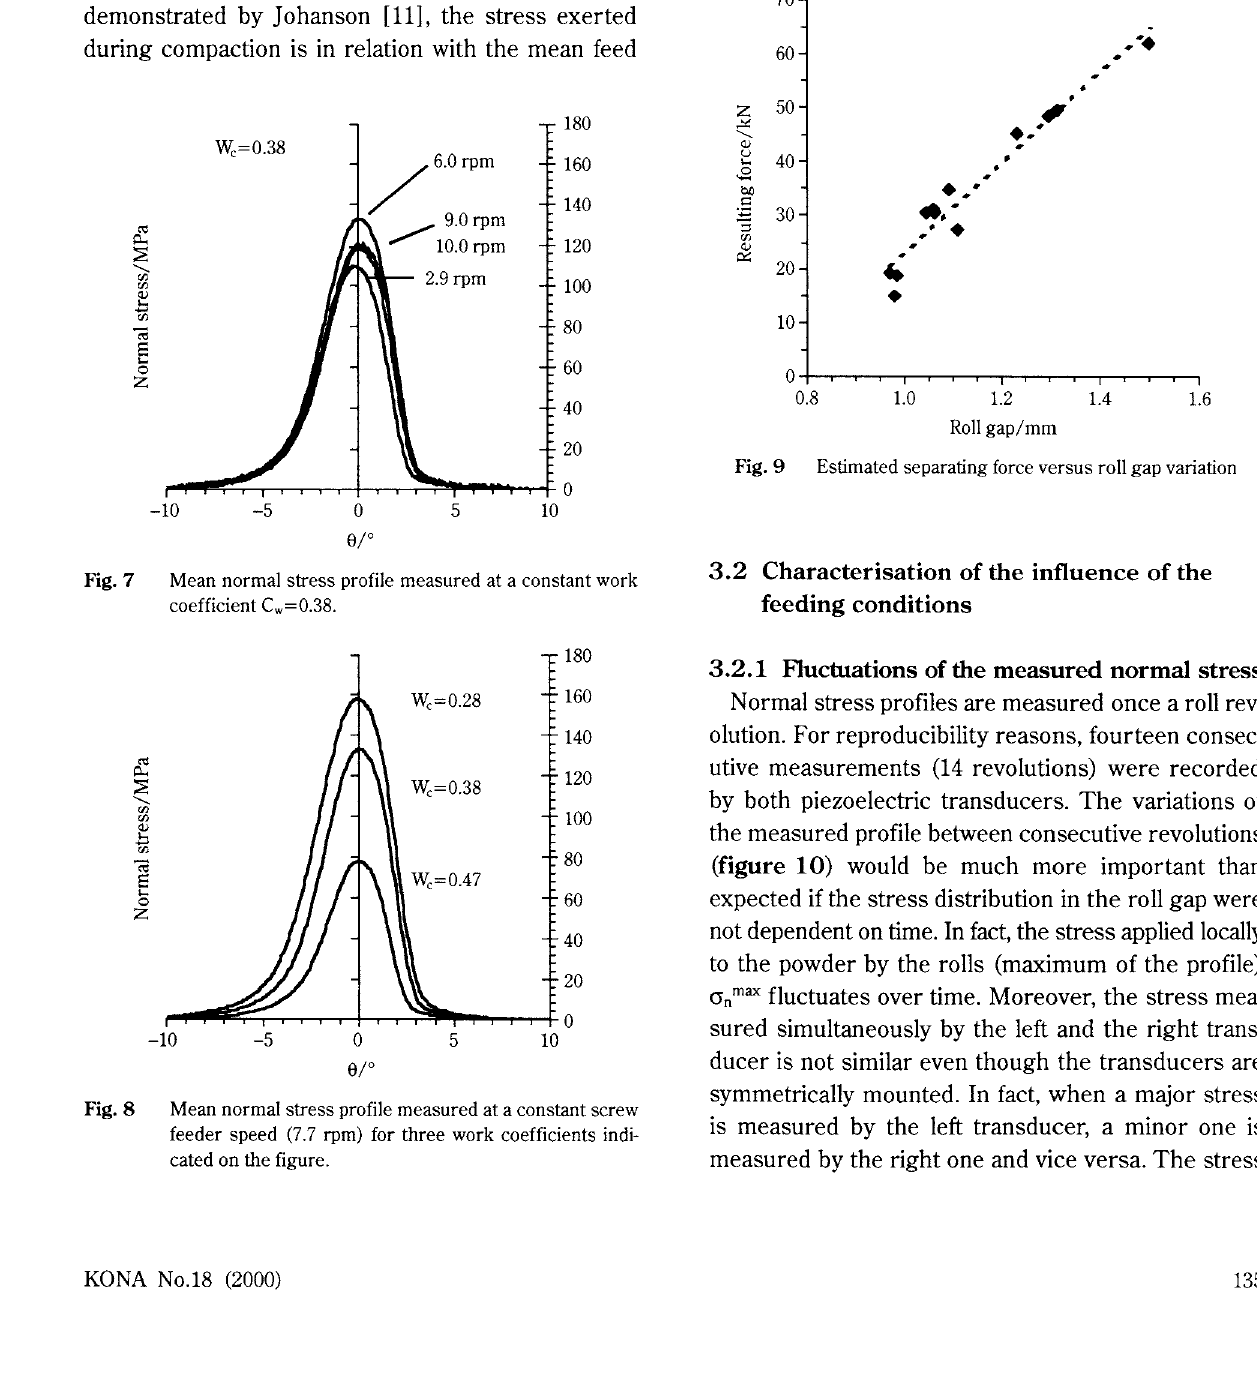
Estimated separating force versus roll gap